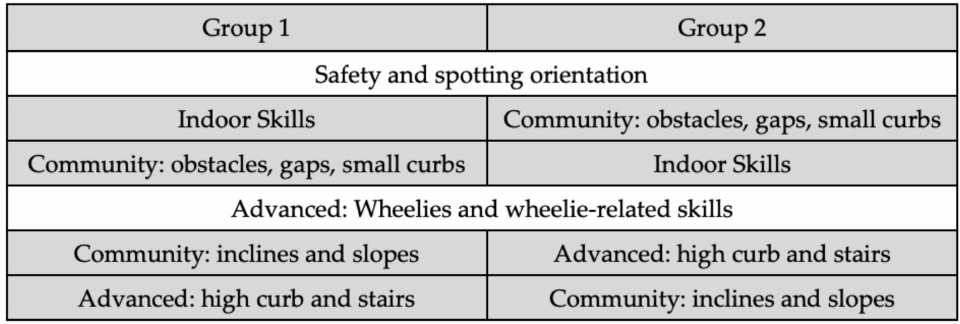
Figure 1. Typical sequence of WST-Q skills training in the bootcamp. Note: WST-Q = Wheelchair Skills Test